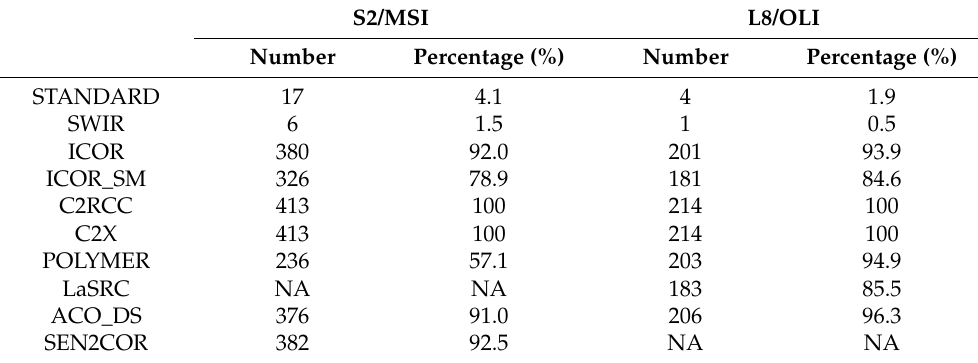
Figure 7. Distributions of the maximum matchups for L8/OLI and S2/MSI in each interval (days). Table 4. Number and percentage of valid matchups for each